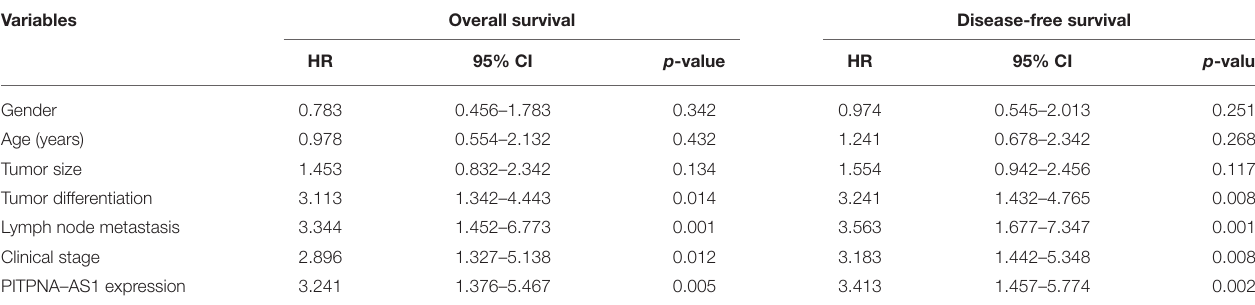
TABLE 3 | Multivariate analyses of prognostic factors in HCC patients. Variables Overall